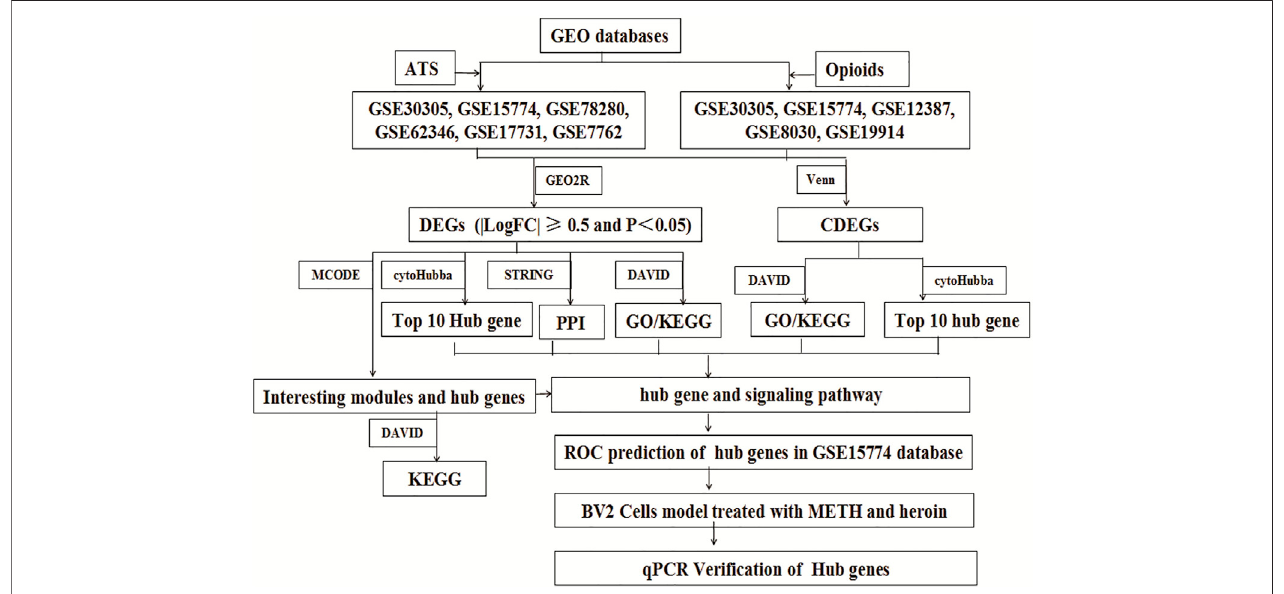
FIGURE 1 | Flow diagram of the study